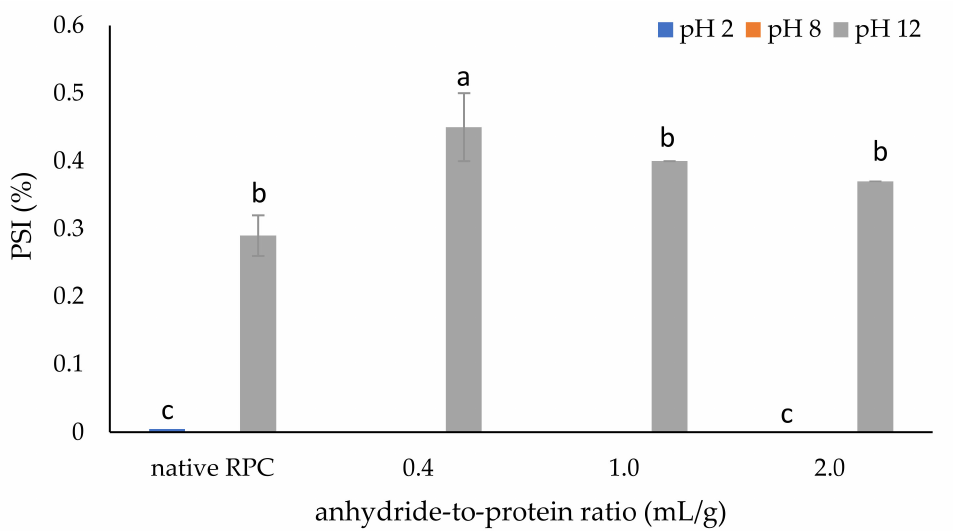
Figure 1. Effect of anhydride-to-protein ratio on the protein solubility index (PSI) of native and acetylated RPC. a, b, c—the same letters within the same analysis indicate values that are not significantly different; RPC—rice protein concentrate; 0.4, 1.0, 2.0—rice protein preparations after acetylation conducted with different concentrations of acetic anhydride